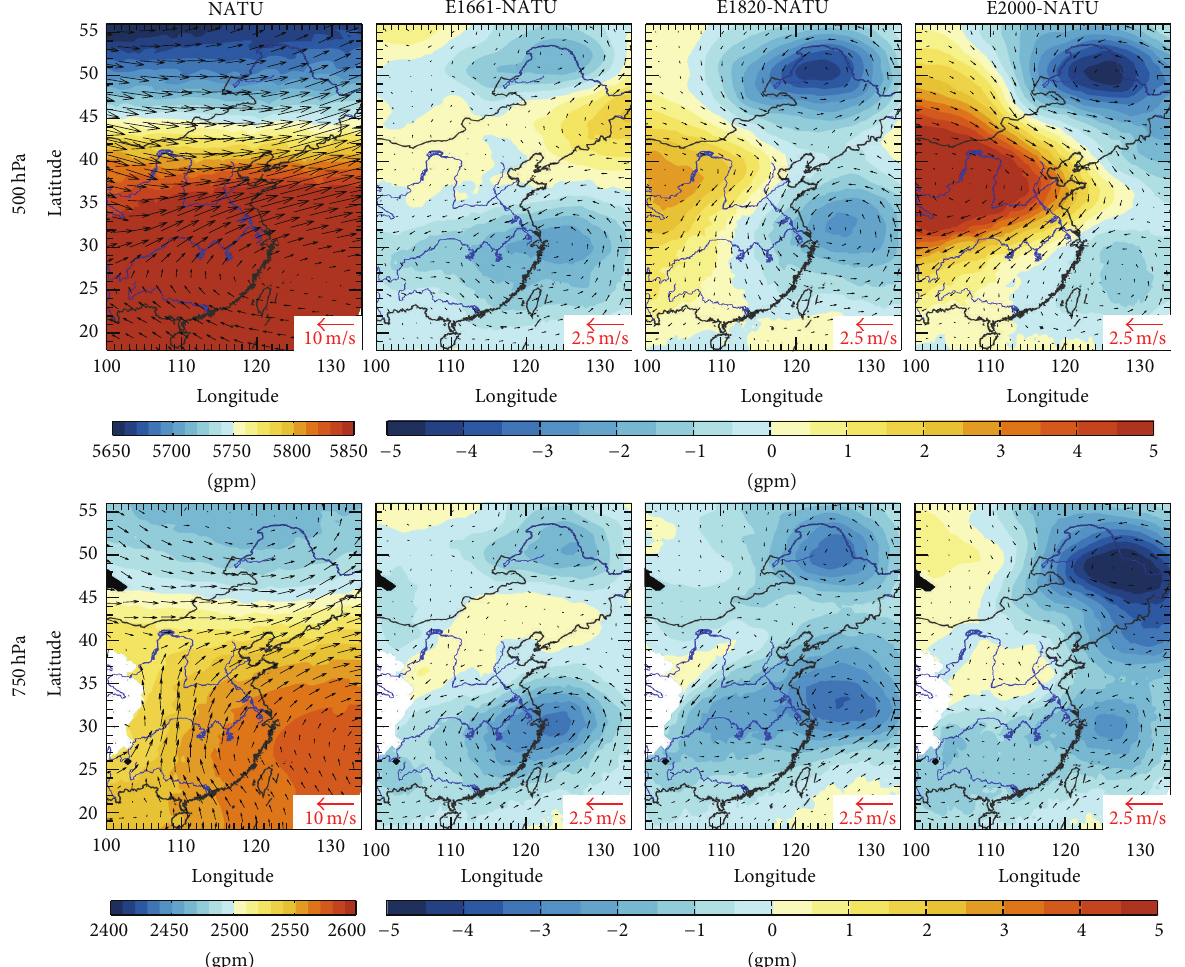
Figure 6: Height (color contours) and wind (arrows) at 500 hpa and 750 hpa underlying natural vegetation and the changes induced by land cover conversions from natural vegetation to cropland in 1661, 1820, and